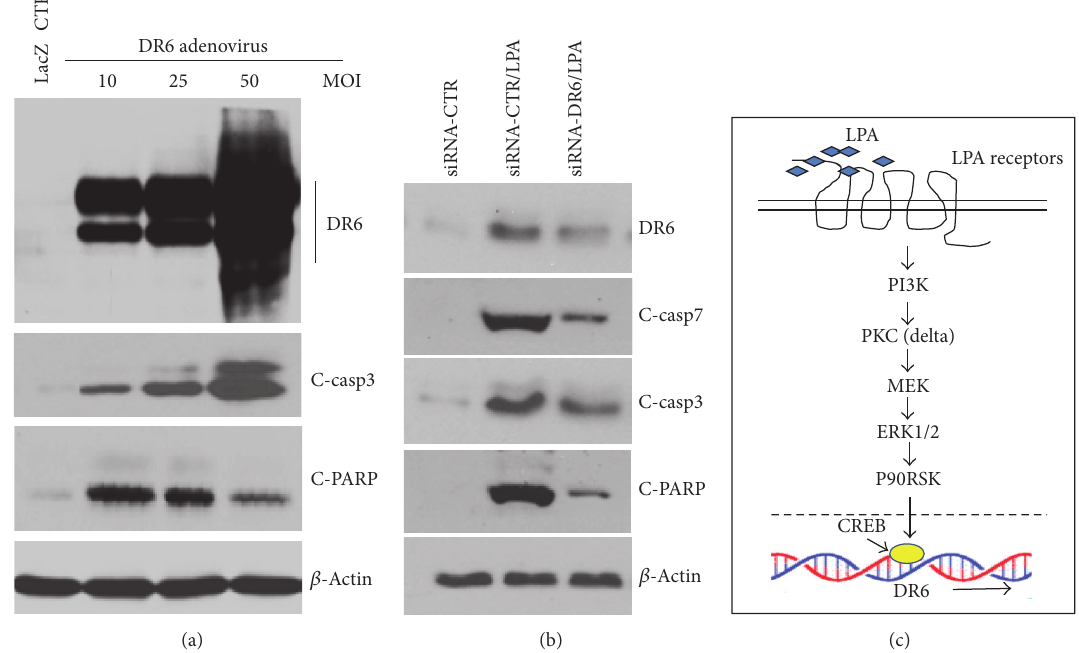
Figure 7: DR6 induction is responsible for LPA-induced apoptosis and sketch of mechanism. (a) Overexpression of DR6 induced apoptosis. HeLa cells were transiently infected with adenoviruses encoding constitutively active DR6 with different multiplicity of infection (MOI); or a control adenovirus carrying the LacZ gene (LacZ). After 24 hr infection, cells were harvested, and the lysates were separated by SDS-PAGE, followed by Western blot analysis for DR6 expression, caspase activation, and PARP cleavage. This membrane was also reprobed with anti- 𝛽 - actin antibody to indicate relative loading of samples (bottom panel). The blot is a representative of 3 independent experiments ( 𝑛 = 3 ). (b) Downregulation of DR6 expression by siRNA attenuates LPA-triggered apoptosis. HeLa cells were treated with LPA in the presence of control siRNA or DR6 siRNA. The expressions of DR6 and activation of caspase-7, caspase-3, and PARP cleavage were measured by Western analysis. 𝑛 = 4 . (c) The proposed molecular mechanism of LPA-induced DR6 expression in HeLa cells. LPA ligand binds to its receptors LPAR1 or LPAR3 to initiate the cell signaling by activation PI3K, followed by the activation of PKC 𝛿 and MEK, which phosphorylate ERK1/2. ERK then activates CREB probably mediated by activation of